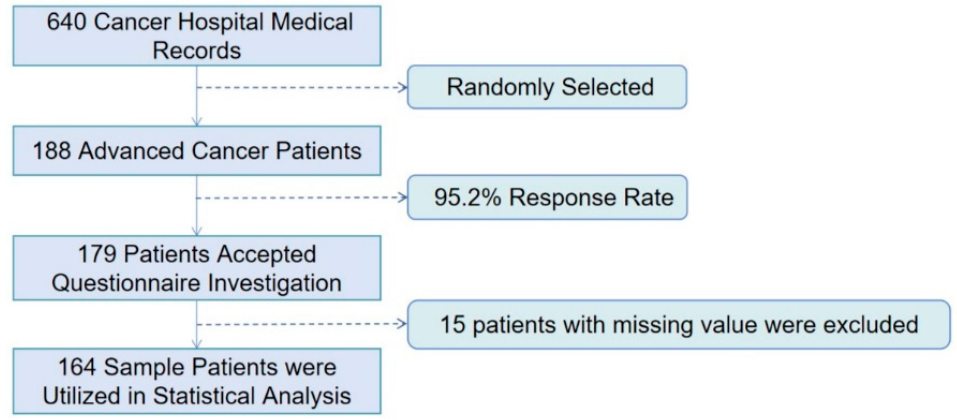
Figure 1. Flow chart illustrating inclusion of survey participants. Between August and November 2018, 188 EOL advanced cancer patients were ran- domly recruited from 640 cancer hospital medical records at a Tertiary A-level hospital in Shandong, China. To be included a patient had to have no cognitive impairments. Prior studies found that a patient’s decision-making can be projection biased; that is patients with severe diseases prefer to make decisions based on current severity [15]: the worse the health status, the more stable the preference [16]. Therefore, three selection criteria were added: patients had to be diagnosed with Stage 3 or 4 cancer; hospitalized receiving